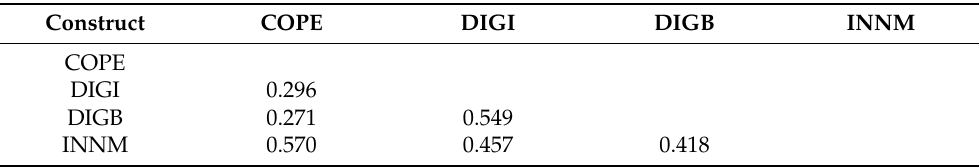
Table 5. Discriminant validity of the model (HTMT).